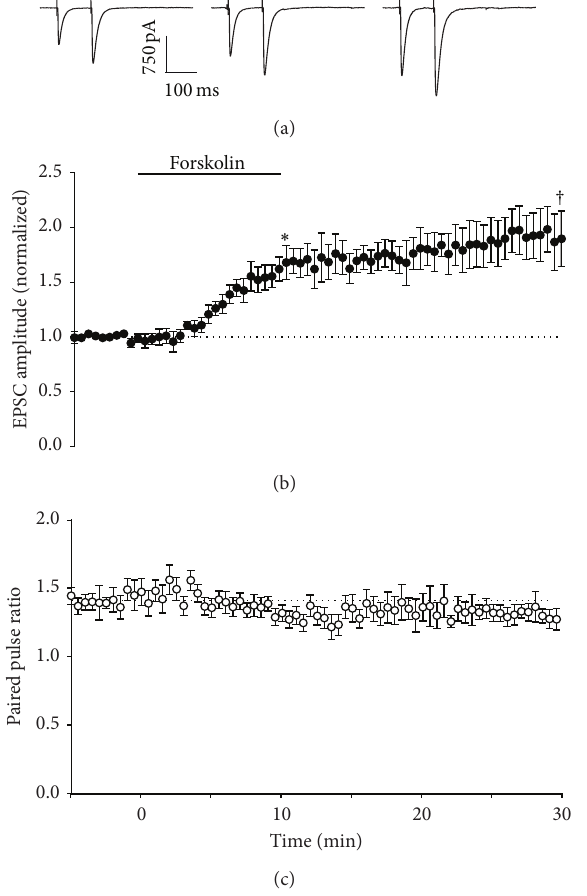
Figure 4: Effect of activation of adenylyl cyclase on Purkinje neu- ron responses. (a) Representative whole-cell recordings of EPSCs generated by paired pulse stimulation (100ms interval) of parallel fibres in transverse cerebellar slices at 0.033 Hz before (first panel), after 10 minutes incubation with 50 𝜇 M forskolin (second panel), and after 20 minutes of washout (third panel). (b) Time course of 50 𝜇 M forskolin effect on amplitude of the first pulse in each pair, with forskolin incubation at the time indicated by the bar. Data are mean ± s.e.m. from 6 cells. ∗ 𝑃 = 0.0039 , † 𝑃 = 0.0115 , one-sample 𝑡 - test. (c) Time course of 50 𝜇 M forskolin effect on paired pulse ratio, with forskolin incubation at the time indicated by the bar. Data are mean ± s.e.m. from 6 cells.